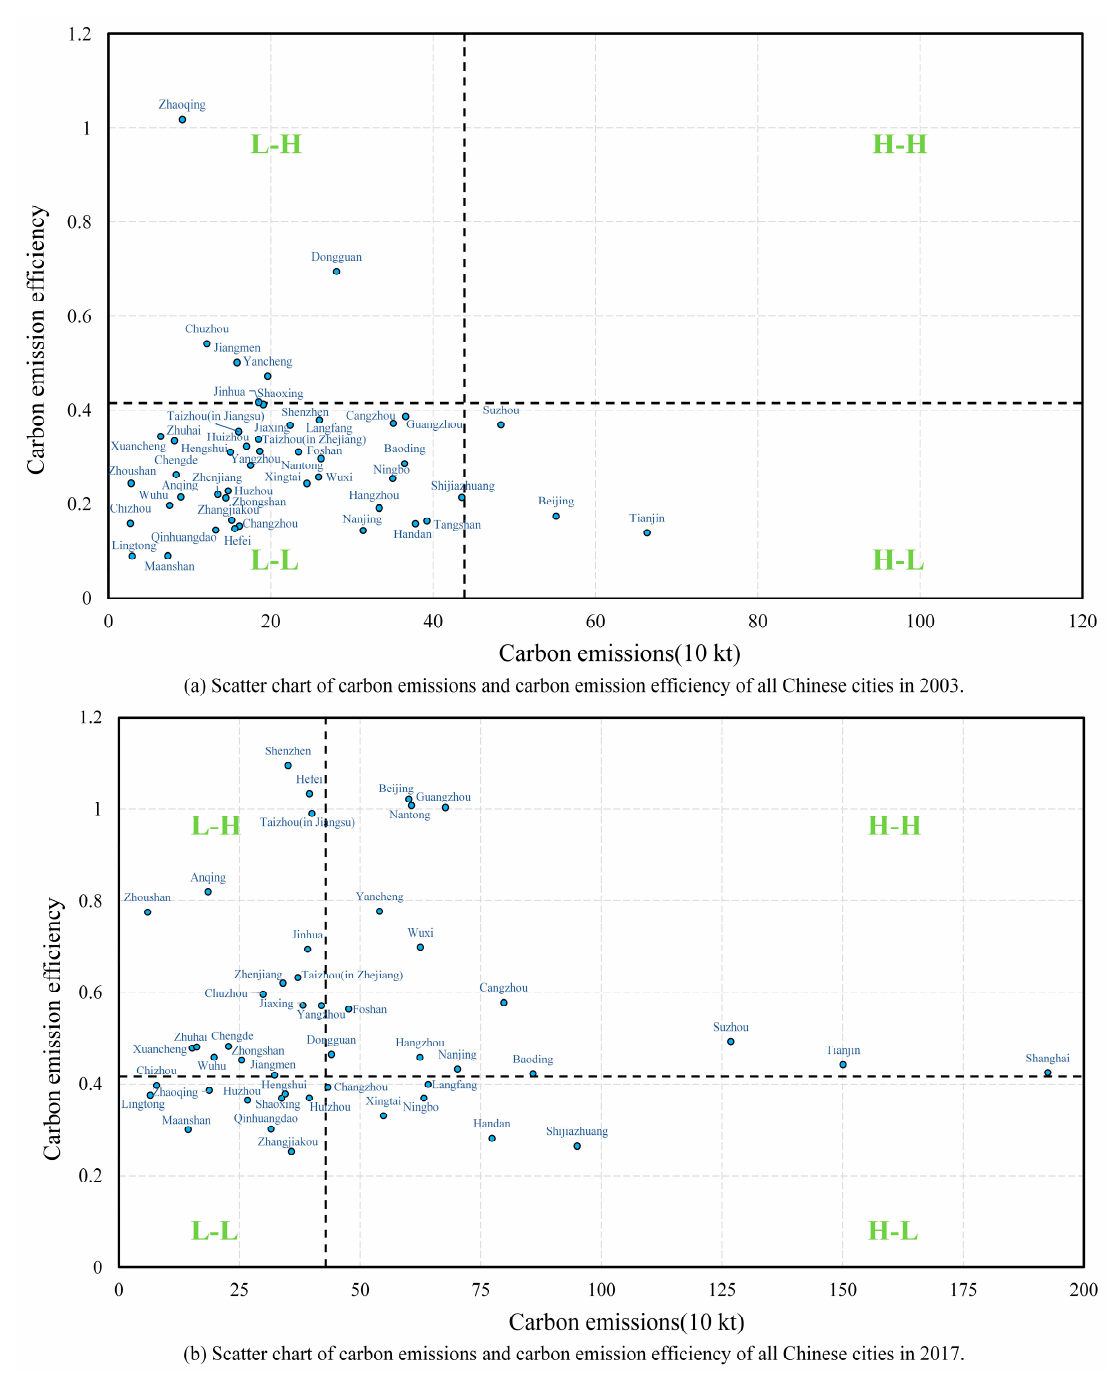
Figure 3. Mechanism of residents’ waste classification behavior. Three years (2003, 2010, 2017) were selected to map the spatial distribution of CEE in the three major urban agglomerations using ArcGIS 10.8 software (Figure 4). Total CEE in the three major urban agglomerations shows an upward trend. While in 2003 there were 28 cities with an efficiency of less than 0.3, there were only 4 in 2017. Moreover, the spa- tiotemporal patterns of CEE had different evolution characteristics. In BTH, low-efficiency cities formed a C-structure surrounding Langfang, Cangzhou, and Hengshui, which had relatively high efficiencies in 2003. In 2010, CEE was significantly enhanced, and the origi- nal higher-efficiency cities expanded into an I-shape along the north–south direction. In 2017, the higher-efficiency cities in BTH were concentrated in the northeast and